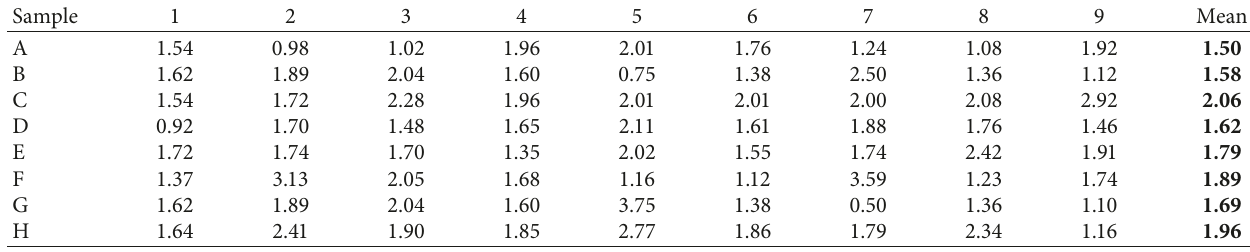
Table 1: Loss of ignition (LOI) values of different samples of hematite ore (in percentage). The mean value in the table represents the mean of nine samples for each channel assigned from A to H.